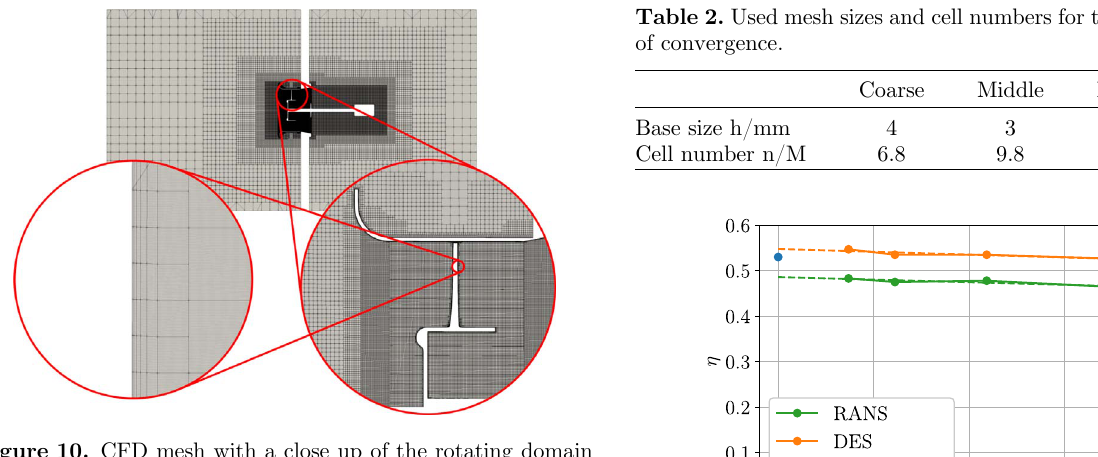
Figure 10. CFD mesh with a close up of the rotating domain and the prism layers on the fan blades to resolve the boundary layer.